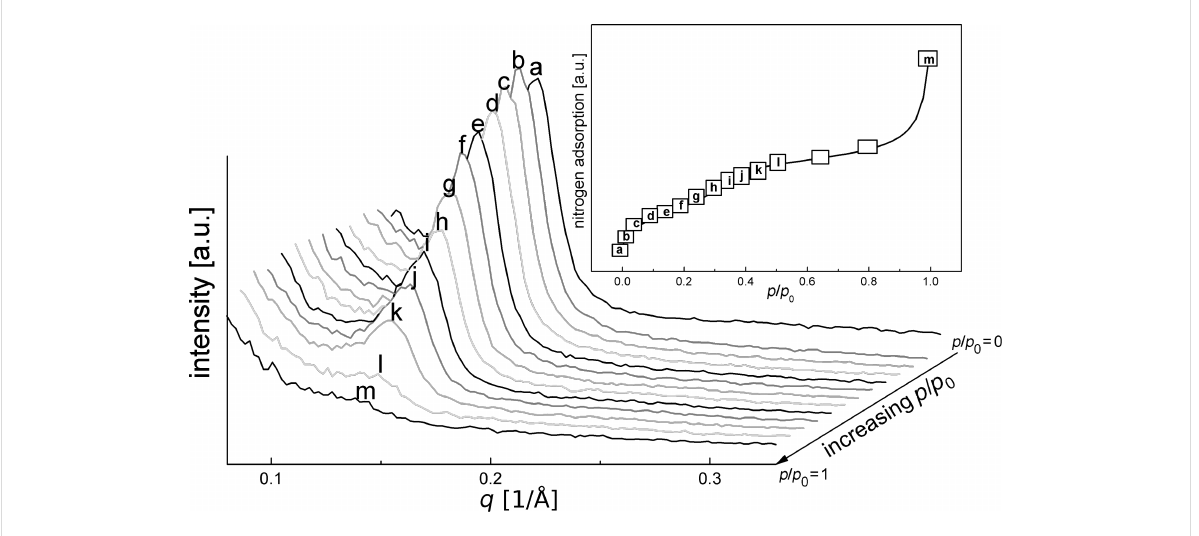
Figure 4: Neutron diffraction patterns of functionalized benzene-PMO-(0.81 mmol SO 3 H·g − 1 ) grafted on silanol groups at small q values at different stages of adsorbed nitrogen.